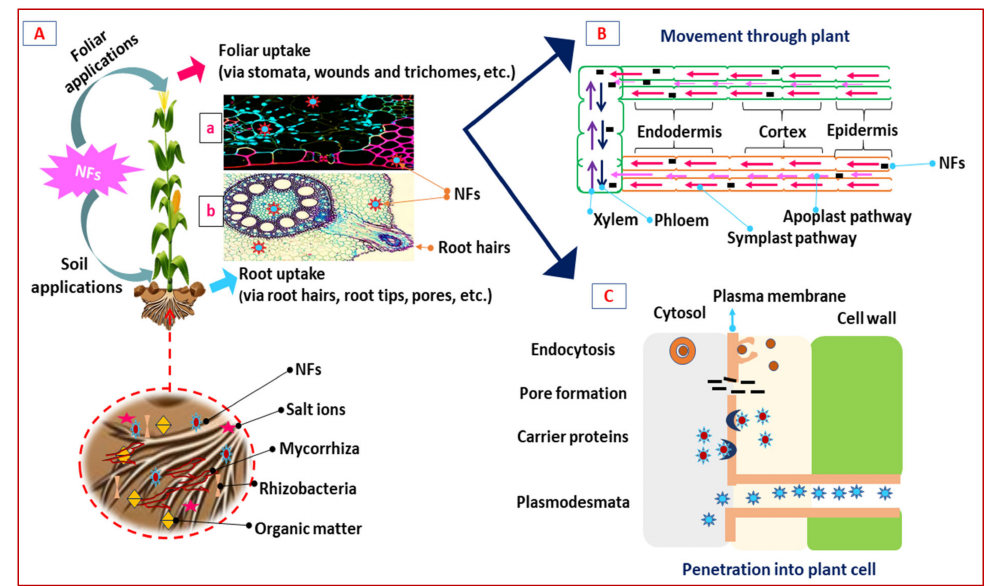
Figure 2. Uptake of NFs via various channels and their translocation paths across multiple plant sections are depicted schematically. ( A ) NF traits affect absorption and translocation in plants: ( a ) T.S. of maize leaf; ( b ) T.S. of maize roots (both images were taken from public databases and are freely accessible). ( B ) NFs may use apoplastic-symplastic pathways for moving up and down. ( C ) Various strategies were proposed for the internal distribution of NFs inside the cells through endocytosis and pore formation mediated by carrier proteins via plasmodesmata.